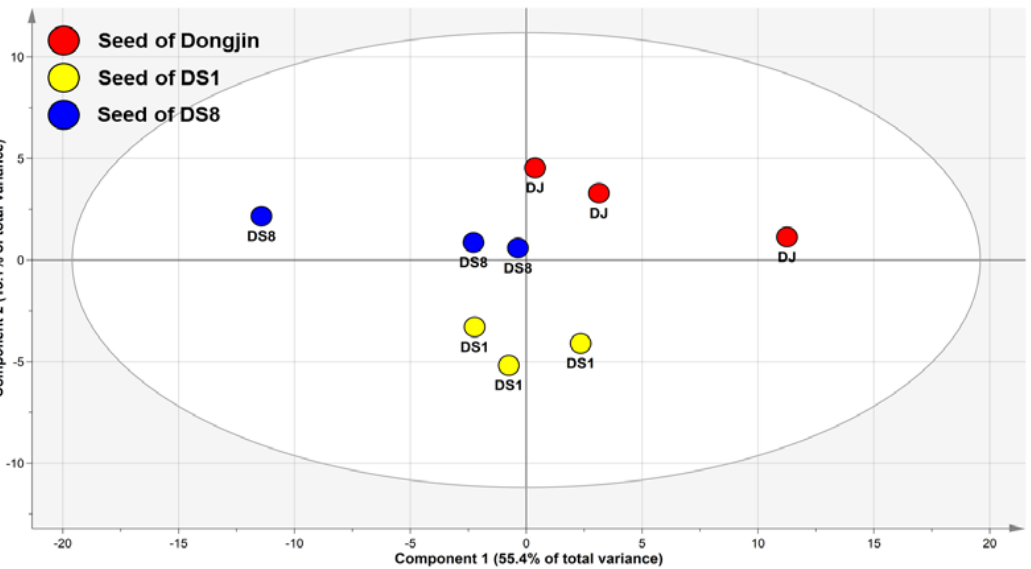
Figure 1. PCA score plot on rice seed. Abbreviations: DJ, Oryza sativa L. cv. Dongjin; DS1, line 1 of transformed rice from DJ with PgDDS and CYP716A47 genes; DS8, line 8 of transformed rice from DJ with PgDDS and CYP716A47 genes.